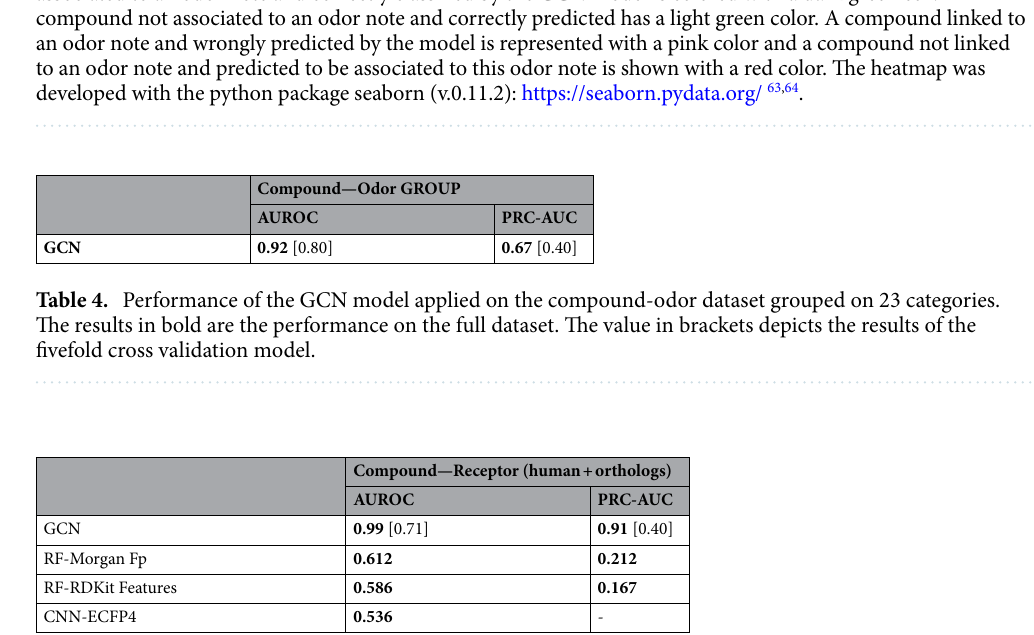
Table 5. Performance of the 4 models applied on the compound-olfactory receptors dataset. The results in bold are the performance on the full dataset. The value in brackets depicts the results of the fivefold cross validation